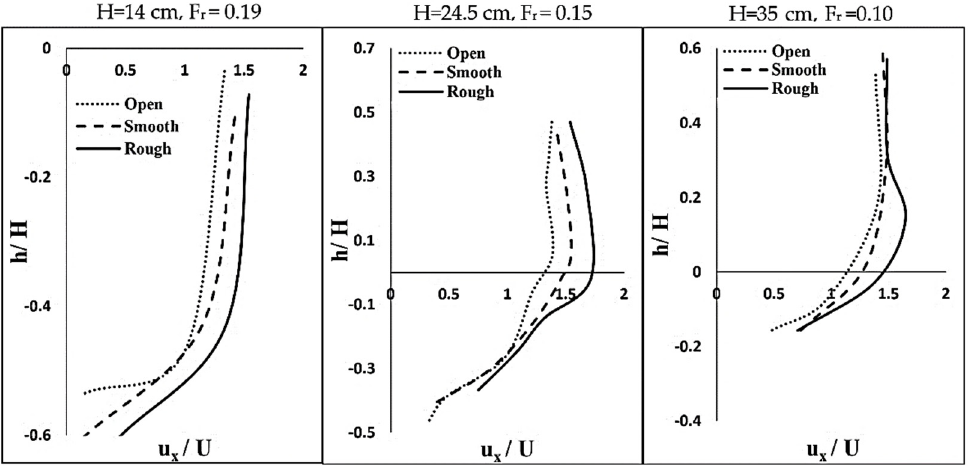
Figure 7. Streamwise velocity profile (u x ) under different surface cover conditions for the spur dike with an orientation angle of 90° for different water depths. ADV measurements subject to +/- 0.25 cm/s error.